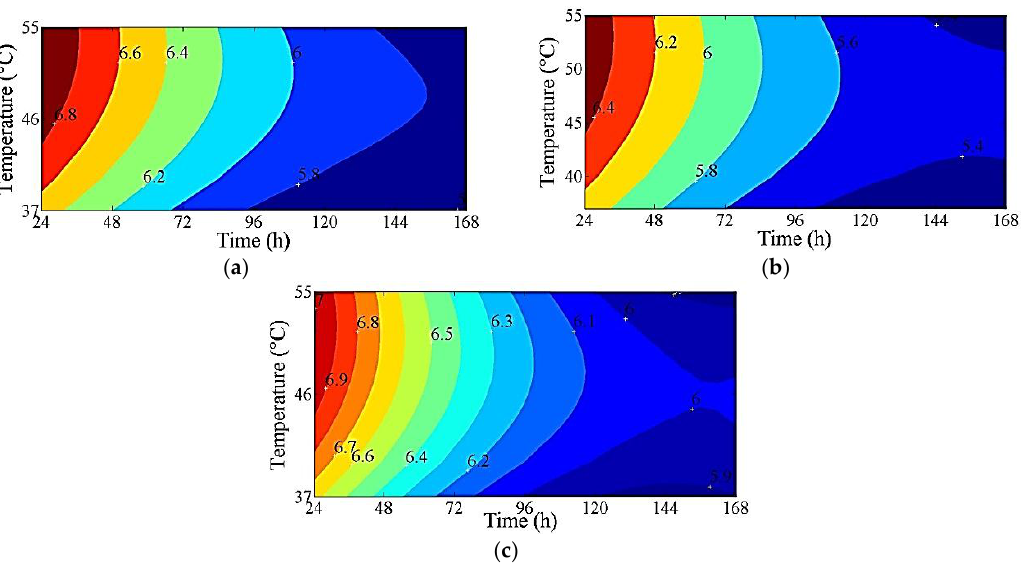
Figure 5. Modeled drop in pH: ( a ) mechanical pretreatment; ( b ) steam explosion; ( c ) chemical pretreatment.